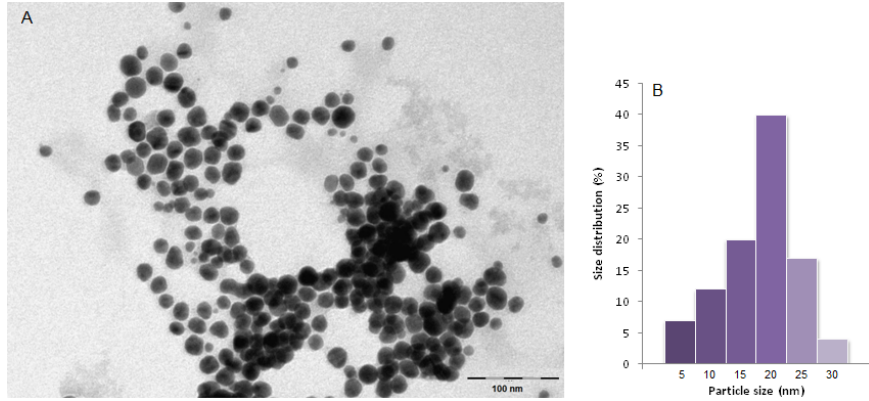
Figure 2. ( A ) TEM image of green synthesized silver nanoparticles and ( B ) size distribution.